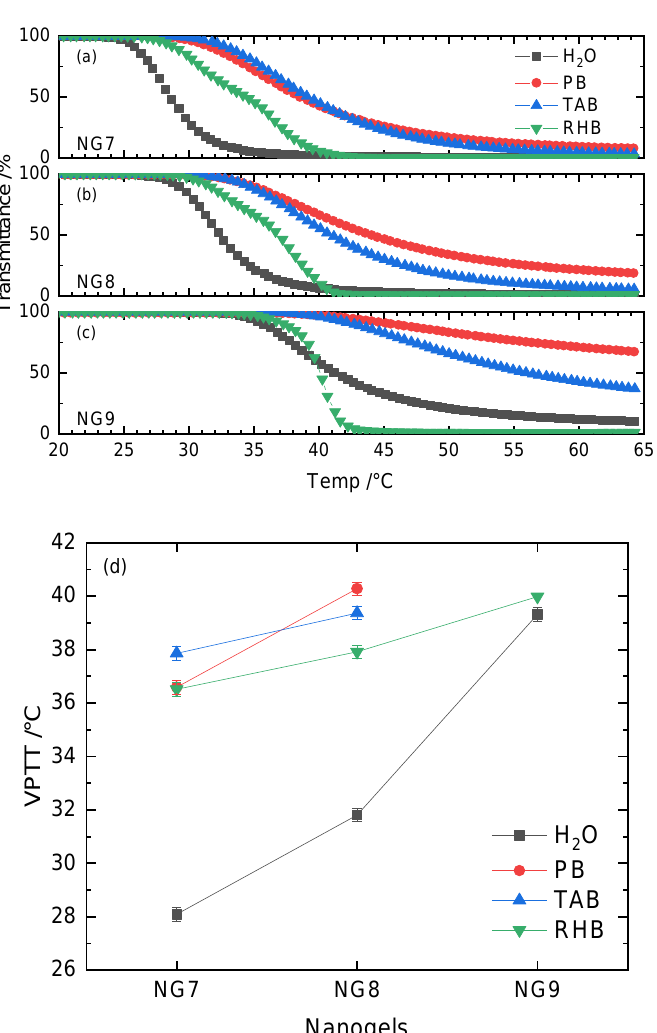
Figure 4. VPTT profiles of ( a ) NG7, ( b ) NG8 and ( c ) NG9 in H 2 O, PB, TAB and RHB. Their corresponding VPTT values are summarized in ( d ).